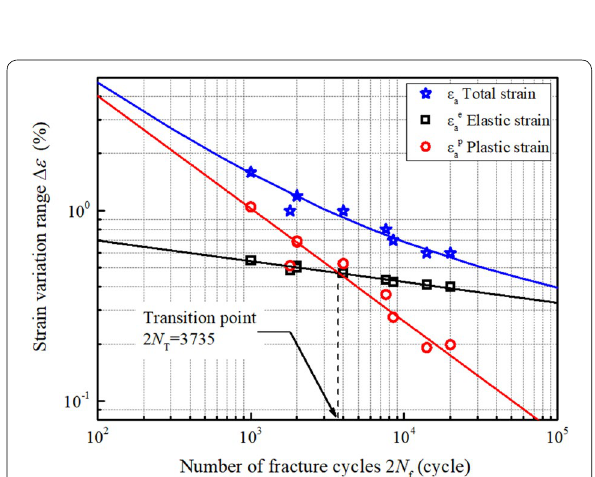
Figure 10 Strain-life curve of the weathering